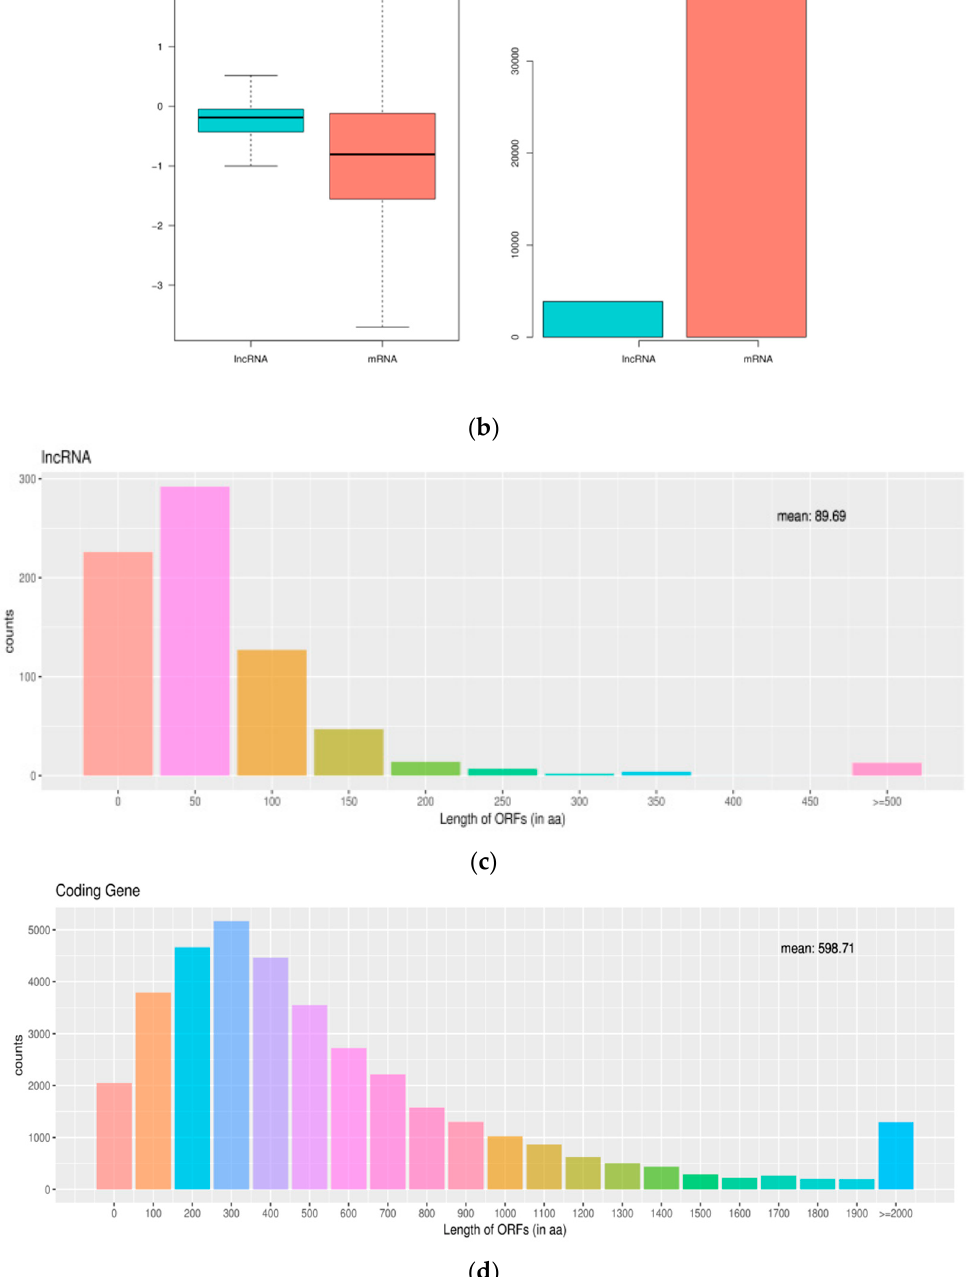
Figure 3. The Characteristics Comparison of Transcripts ( a ): Distribution of exon number for mRNAs and lncRNAs. ( b ): Expression level and a number of mRNAs and lncRNAs. ( c ): Distribution of lncRNA ORFs length. ( d ): Distribution of mRNA ORFs length.